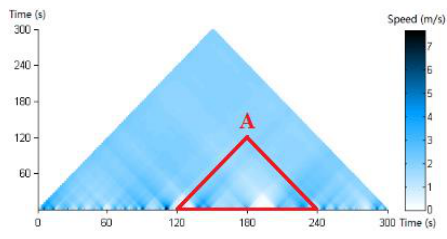
Figure 3. Illustration of the CTM.